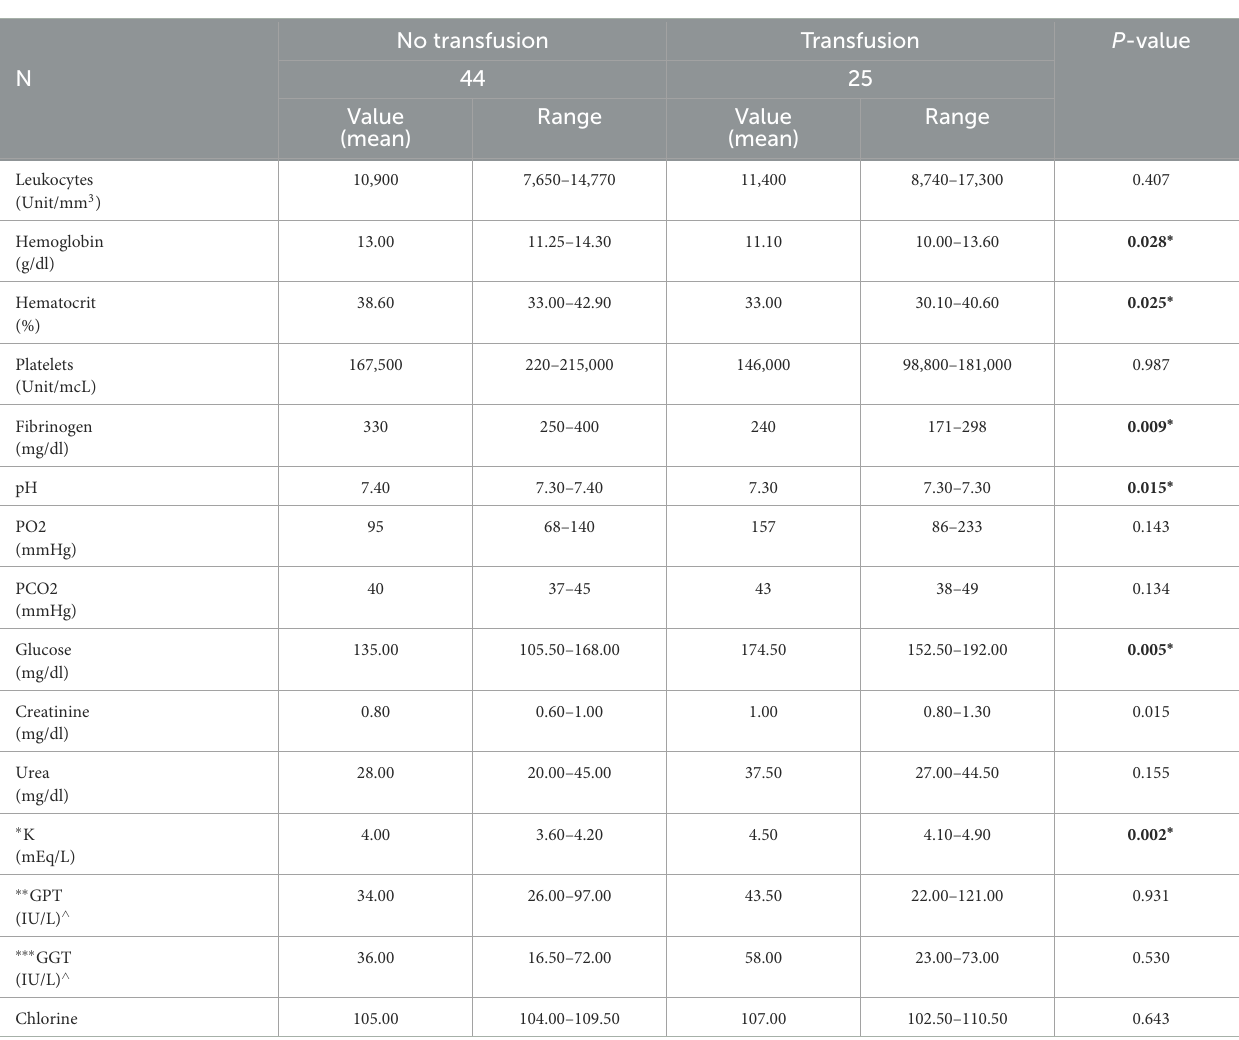
TABLE 3 Laboratory profiles.